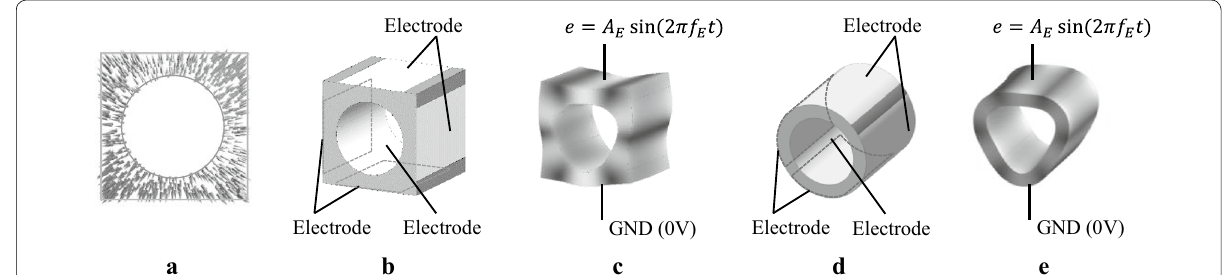
Fig. 2 a Polarization direction of the bulk piezoelectric stator in piezoelectric analysis model. b Electrodes placed on the bulk stator, c three-wave mode generated in the bulk piezoelectric stator when a voltage is applied. d The model of the cylindrical bulk stator, and e the three-wave mode on the cylindrical bulk stator